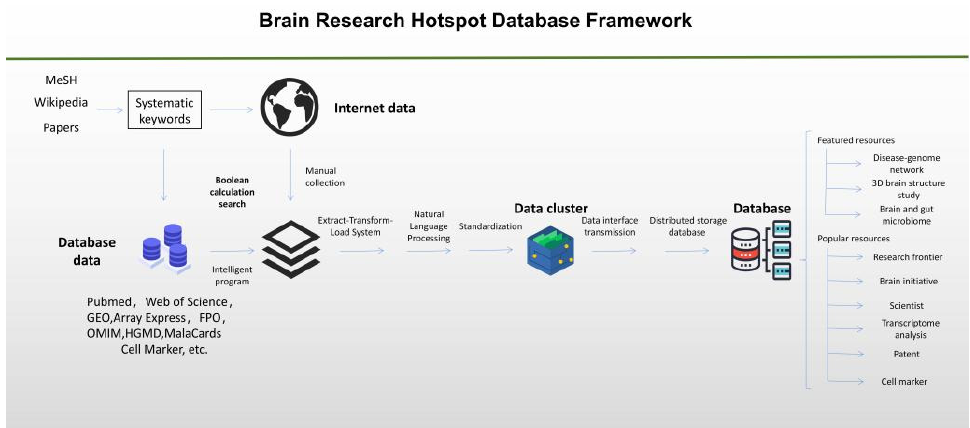
Figure 1. The framework of the BRHD. It mainly includes three parts: data collection, natural language processing, database creation.